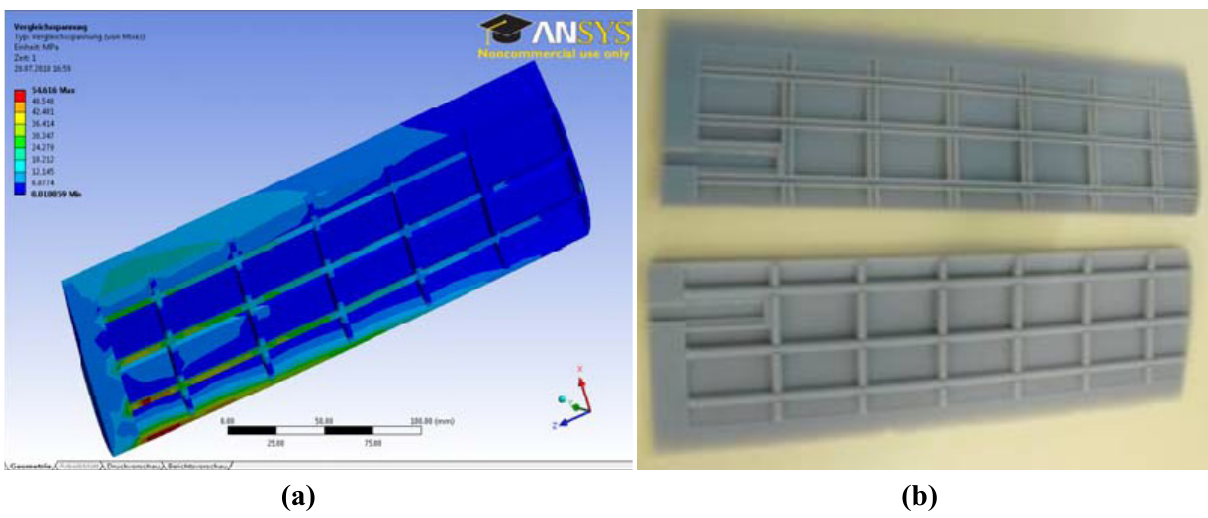
Figure 4. (a) Von Mises stress simulation of the internal structure of the turtle hydrofoil. (b) Rapid prototype implementation of the turtle